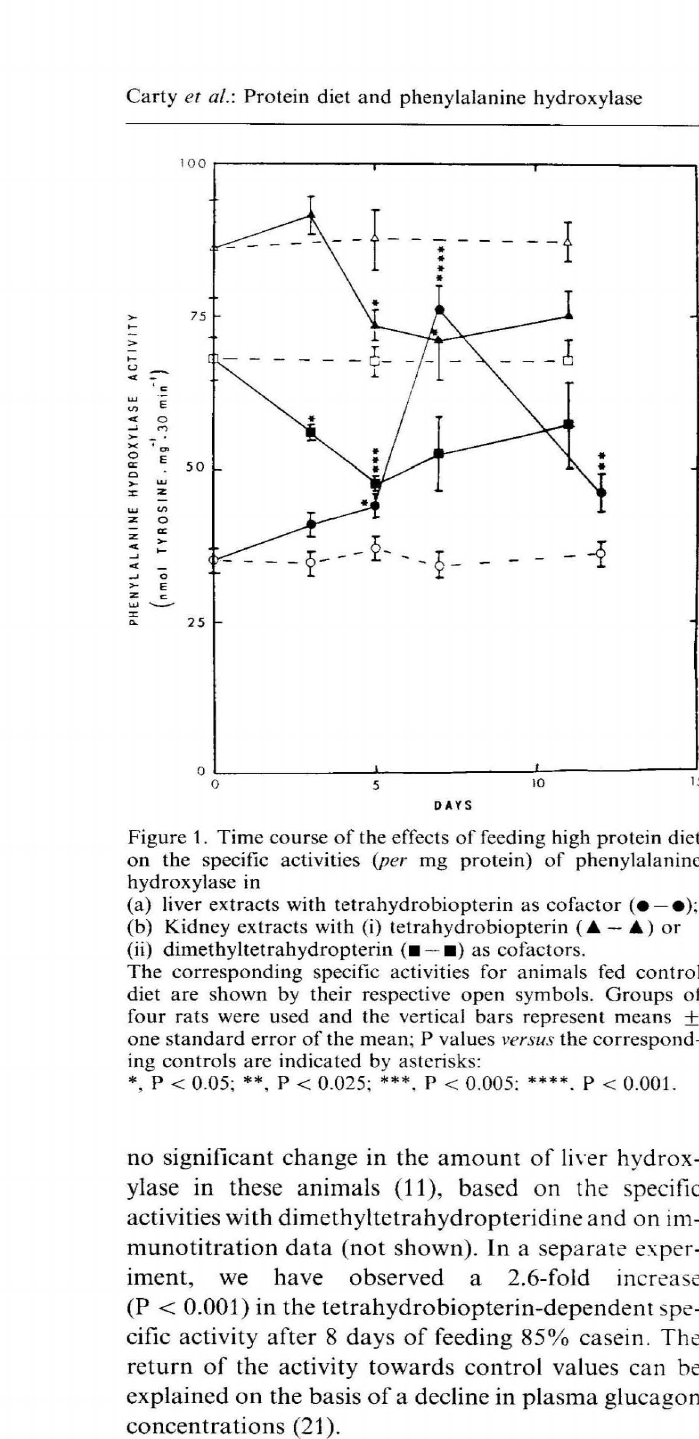
Figure 1. Time course of the effects of feeding high protein diet on the specific activities (per mg protein) of phenylalanine hydroxylase in (a) liver extracts with tetrahydrobiopterin as cofactor (e-e); (b) Kidney extracts with (i) tetrahydrobiopterin (A - A) or (ii) dimethyltetrahydropterin (_ - _) as co factors. The corresponding specific activities for animals fed control diet are shown by their respective open symbols. Groups of four rats were used and the vertical bars represent means ± one standard error of the mean; P values versus the correspond ing controls arc indicated by asterisks: *, P < 0.05; **, P < 0.025; ***, P < 0.005: ****. P <